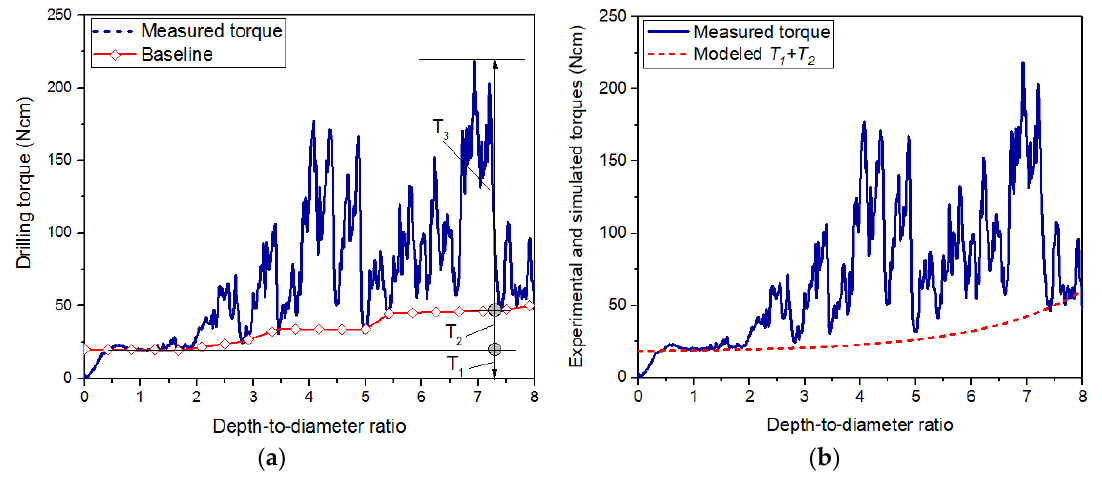
Figure 4. Example of measured data and ( a ) its baseline and ( b ) model torques T 1 + T 2 . At first, the baseline of the real measured torque was made, as shown by the red line-diamond in Figure 4a. A regression process was then applied using the model in Equation (6) to calibrate the value of the coefficient A . Figure 4b shows a result of the processes. Details of the calibration data are listed in Table 4. Table 4. Cutting torque T 1 from CD and UAD